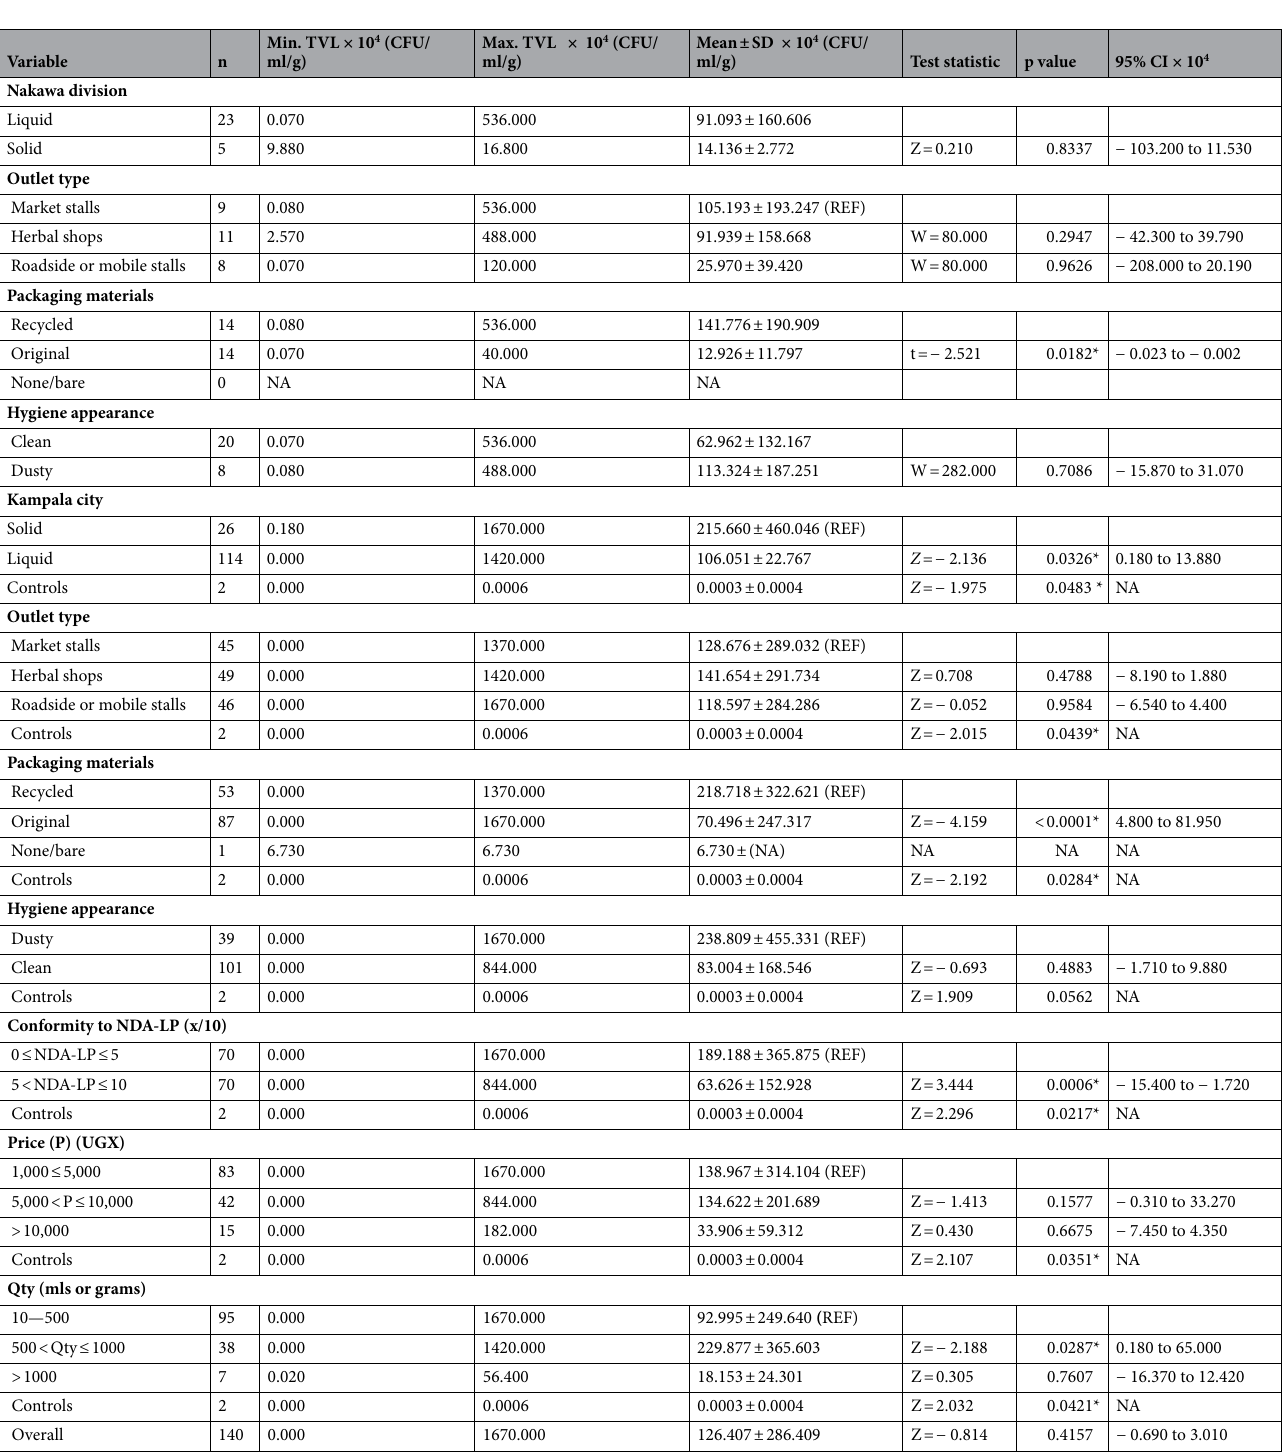
Table 3. Total viable loads (TVL) of bacterial isolated from selected herbal medicines sold in Kampala City. N number of samples, Min minimum, Max maximum, CFU colony forming units, ml milliliter, g gram, NA significant (<